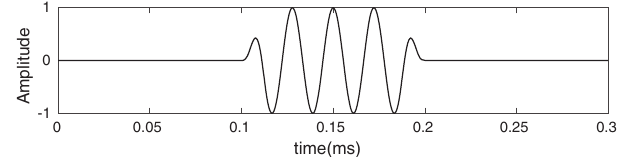
Figure 4. Signal ( “ sinusoidal burst ” ) emitted by sources in numerical simulations.